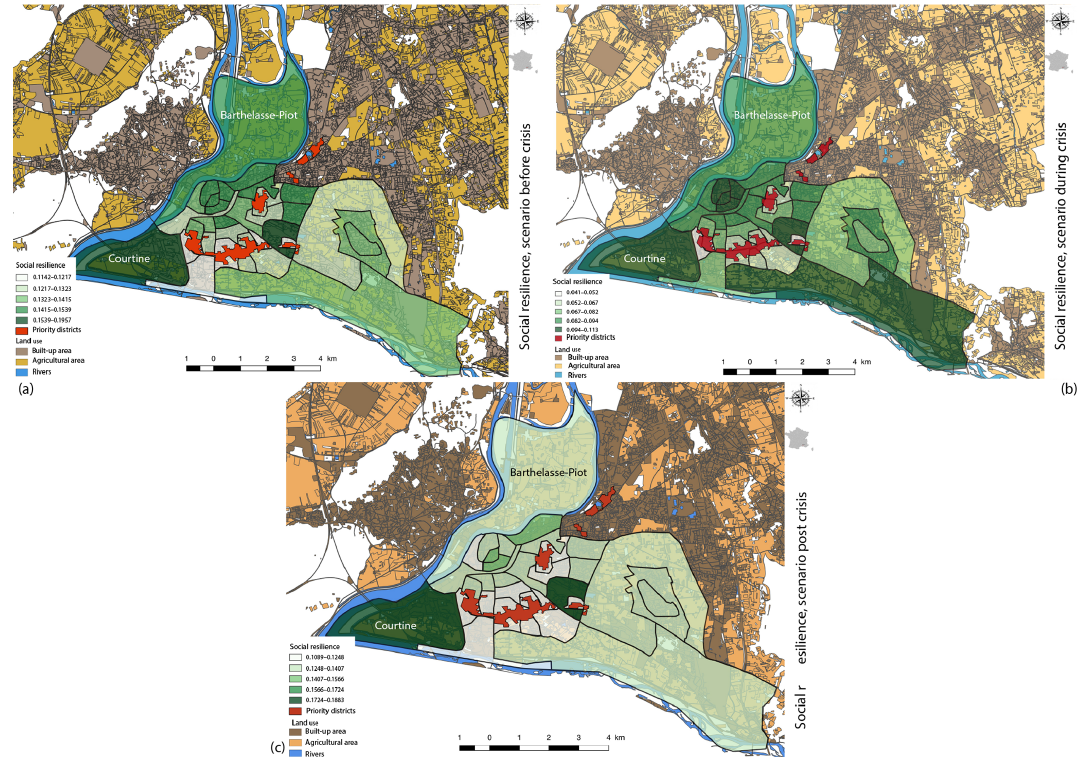
Figure 10. Social resilience indicator – multi-scenario, Avignon scale (IRIS-scale analysis). Panel (a) identifies the most resilient areas (greener) according to the social resilience characteristics before a crisis, panel (b) identifies the most resilient areas according to the social characteristics during a crisis and panel (c) identifies the most resilient areas according to the social characteristics after a crisis – © Open Database License, “ODbL”